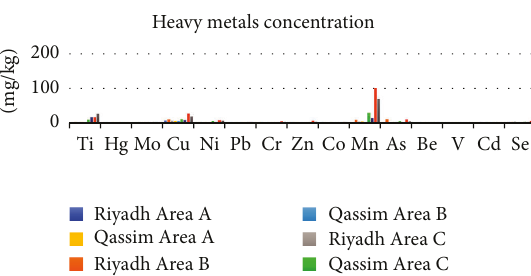
Figure 1: The average concentration (mg/kg) of heavy metals at sites A, B, and C of Riyadh, Qassim, and Medina.